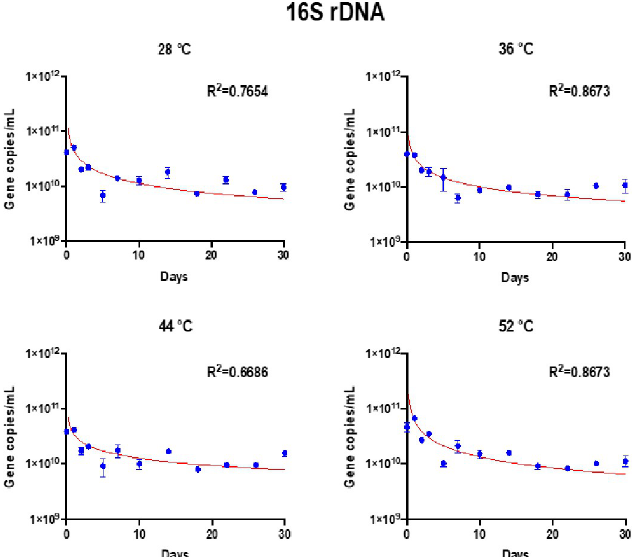
Fig 6. 16S rRNA gene in anaerobic digestion over time. Bars represent standard errors. Blue dots represent the mean value of triplicate reactors under each temperature.